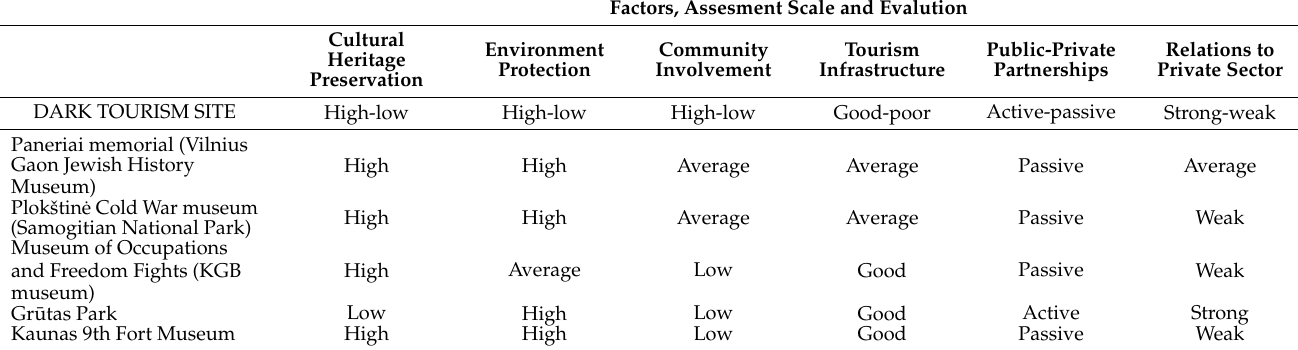
Table 3. Evaluation of Lithuanian Dark tourism sites sustainability based on Relationship-Based Paradigm of Sustainable Tourism by Hassan